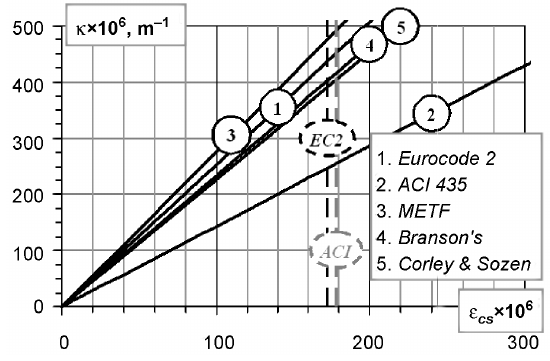
Fig. 7. Shrinkage curvatures of the beam P3-2Pd